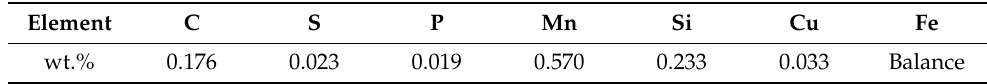
Table 1. Chemical composition of structural steel Q235. Element